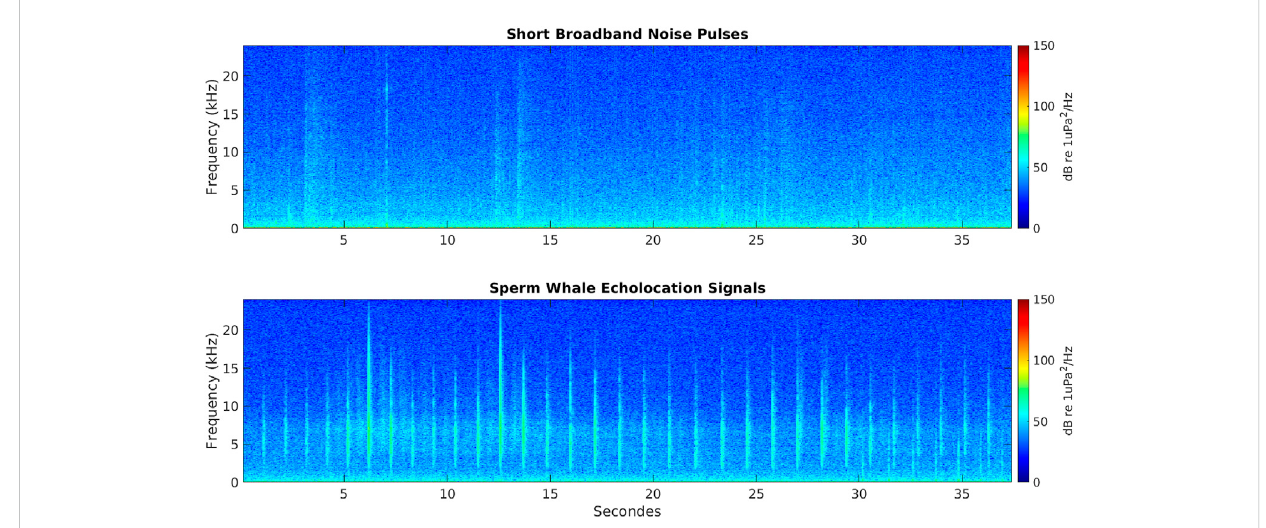
FIGURE 3 Spectrogram of a 37.5 s of data showing short broadband noise pulses in the bandwidth of sperm whales ’ echolocation signals (top panel); and spectrogram of a 37.5 s of data showing echolocation signals of a sperm whale (bottom